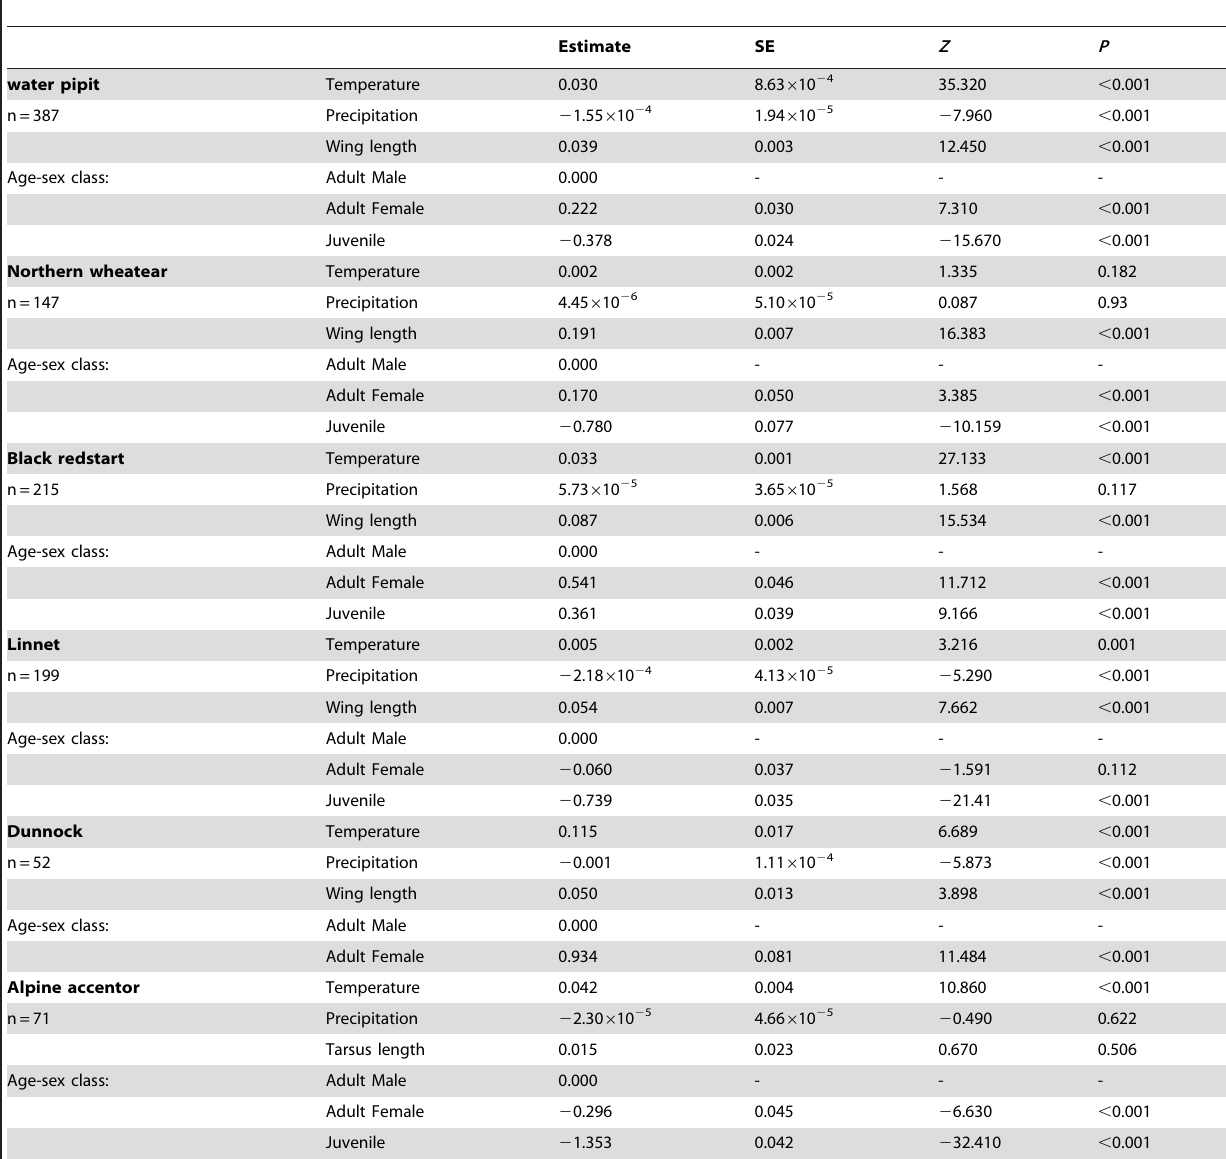
Table 3. Results of generalized linear mixed models testing for the relationship between mite intensity and climate